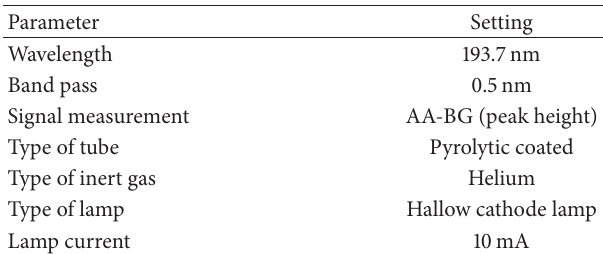
Table 1: Measurement condition for determination of arsenic